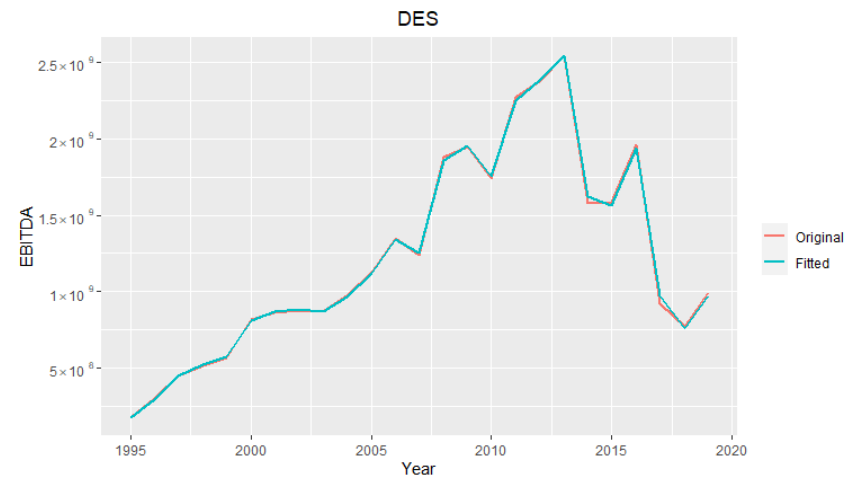
Figure 6. DES model for the EBITDA index with λ = 0.8.